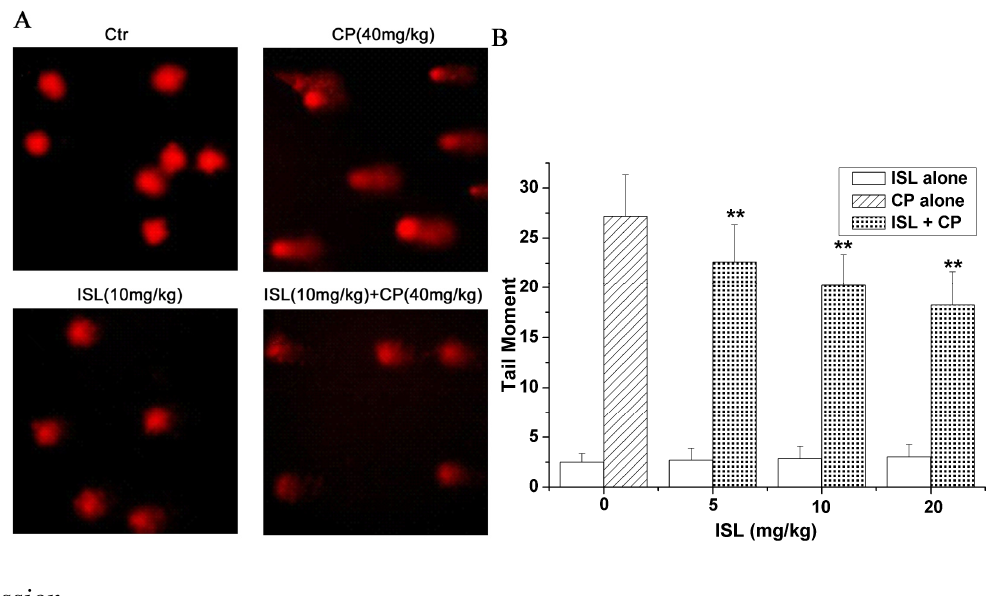
Figure 6. Pretreatment with ISL inhibits CP-induced DNA-damage. Mice were pretreated with ISL (5, 10, 20 mg/Kg) before CP treatment for 3 consecutive days. After CP (a single dose of 40 mg/Kg) treatment for 24 h, blood was obtained from murine tail tips. Comet assay was performed as described in Materials and Methods. ( A ) Representative images of Comet assay. ( B ) The tail moment was measured by CASP software. The mean value of the tail moment in a particular sample was taken as an index of DNA damage in this sample. Data are presented as mean ± S.D. from 10 individual treatments. * p < 0.05, ** p < 0.01 versus CP-treated